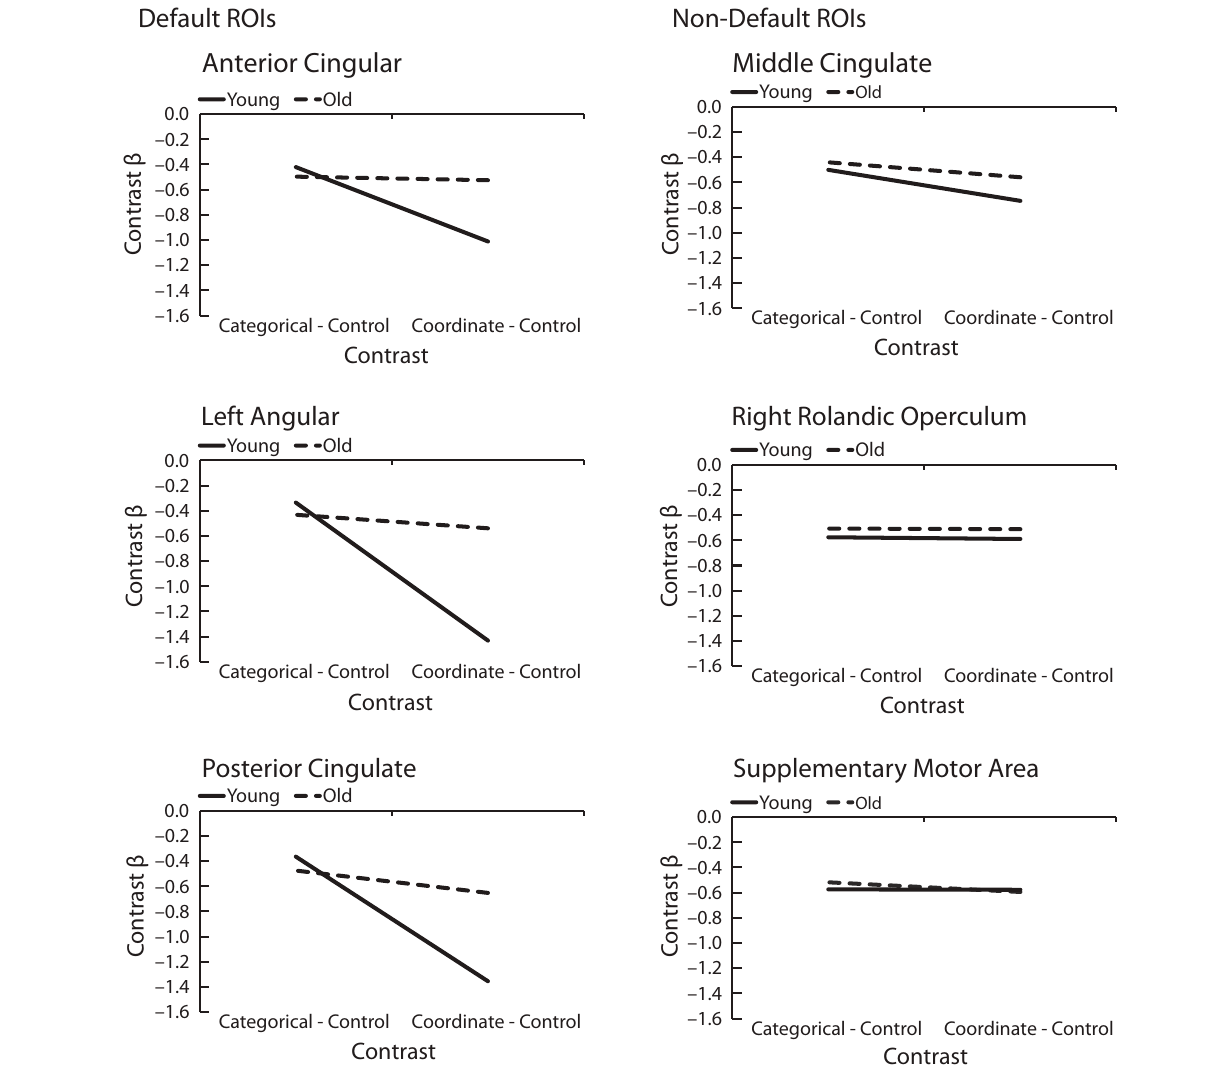
FIGURE 4 | Age differences in categorical and coordinate deactivations in default and non-default ROIs. Contrast betas for young and old groups were extracted from ROIs defi ned by a control–task